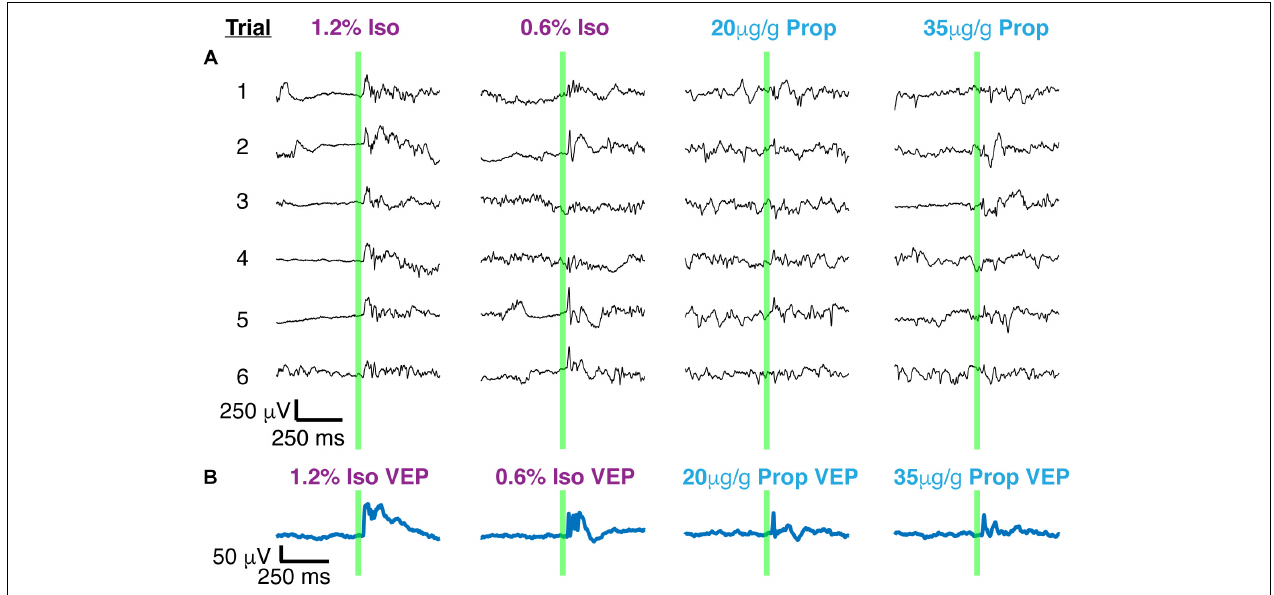
FIGURE 4 | Single trials of visual evoked potentials under isoflurane and propofol both have high trial by trial variability. (A) Six out of 100 randomly chosen individual flash evoked potentials (thin black traces) under high and low doses of each anesthetic: isoflurane, propofol. (B) The average VEP over 100 trials for each anesthetic concentration. The flash is denoted by the green vertical line in both